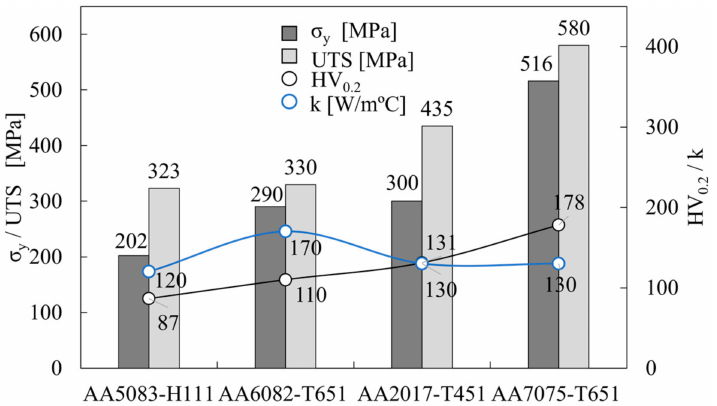
Figure 4. Base material properties: yield strength ( σ y ), ultimate tensile strength (UTS), hardness (HV 0.2 ) and thermal conductivity (k).